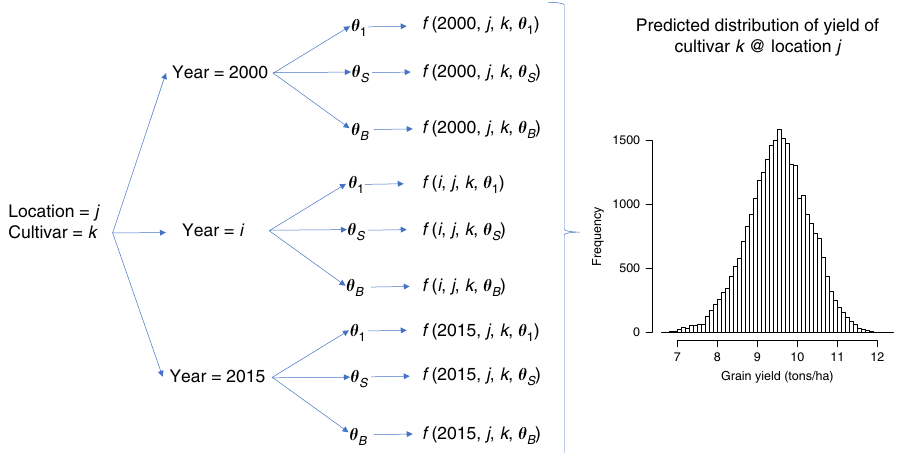
Fig. 4 Monte Carlo simulation. Indices i, j, k , and s index year (2000 – 2015), location ( j = 1, … , 16 locations), cultivar (i.e., the SNP genotypes, k = 1, … ,28 cultivars) and sample from the posterior distribution of model parameters ( s = 1, … ,B, B = 20,000).